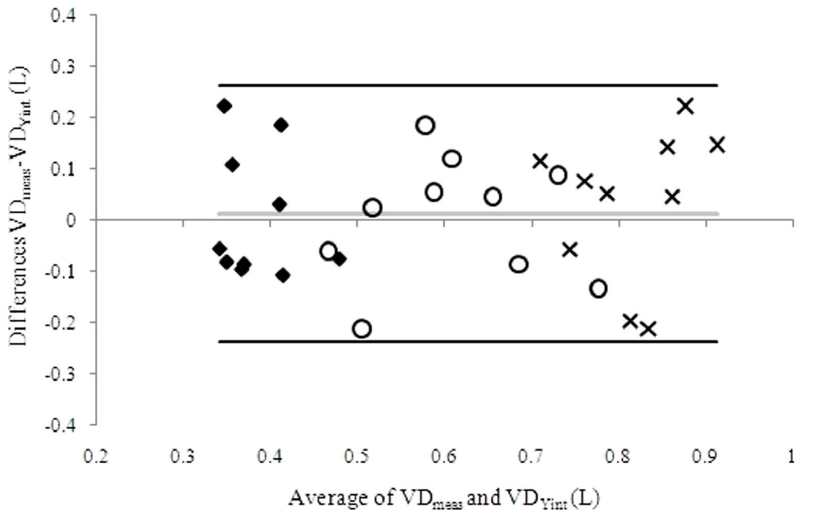
Figure 3. Bland and Altman plot of estimated dead space (DS) volume calculated as VE Yint /RR Yint (VD Yint ) and measured DS volume (VD meas ) at rest, calculated as (1–863/P a CO 2 (VE/VCO 2 )*VT) for heart failure patients with 0 mL (diamonds), 250 mL (circles) and 500 mL (crosses) of additional DS. The grey line identifies the mean difference of VD meas - VD Yint; the black lines identify the mean difference of VD meas - and VD Yint 6 1.96*standard deviation. P a CO 2 = arterial carbon dioxide pressure; VE=ventilation; VT=tidal volume.